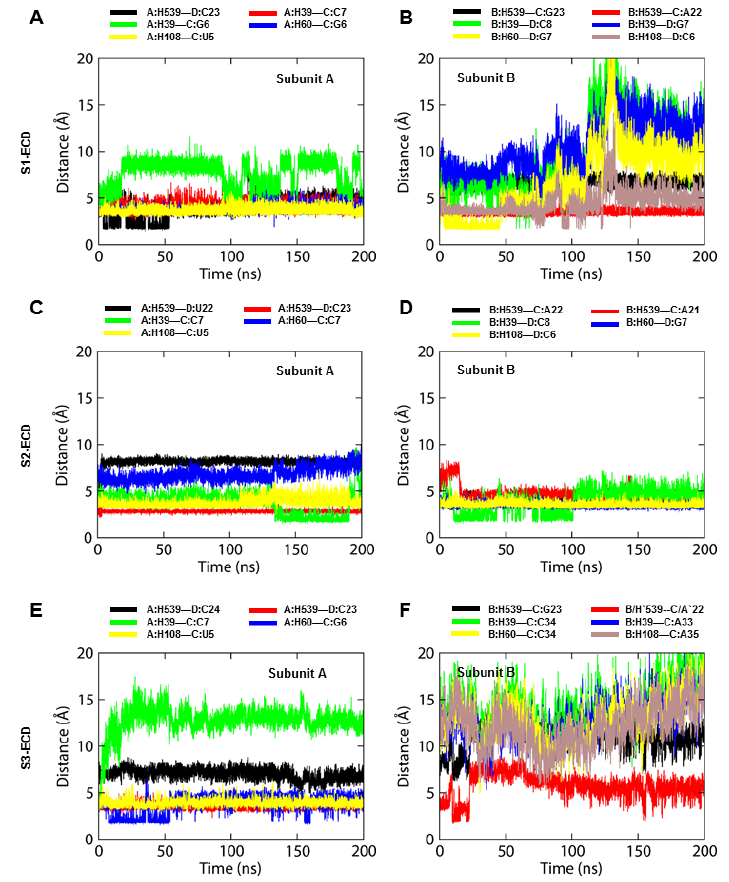
Figure 4. The distance between the key histidine residues of TLR3 and the phosphate groups of the dsRNA backbone. ( A – F ) Intermolecular distances between the imidazole rings of H539, H39, H60, and H108 and the phosphate groups of the dsRNA backbone in three MD simulation systems (replicate 2) as a function of time. Distances were calculated for both chains of the TLR3-dsRNA complex. S1, S2, and S3 represent replicate 2 of sets 1, 2, and 3, respectively.